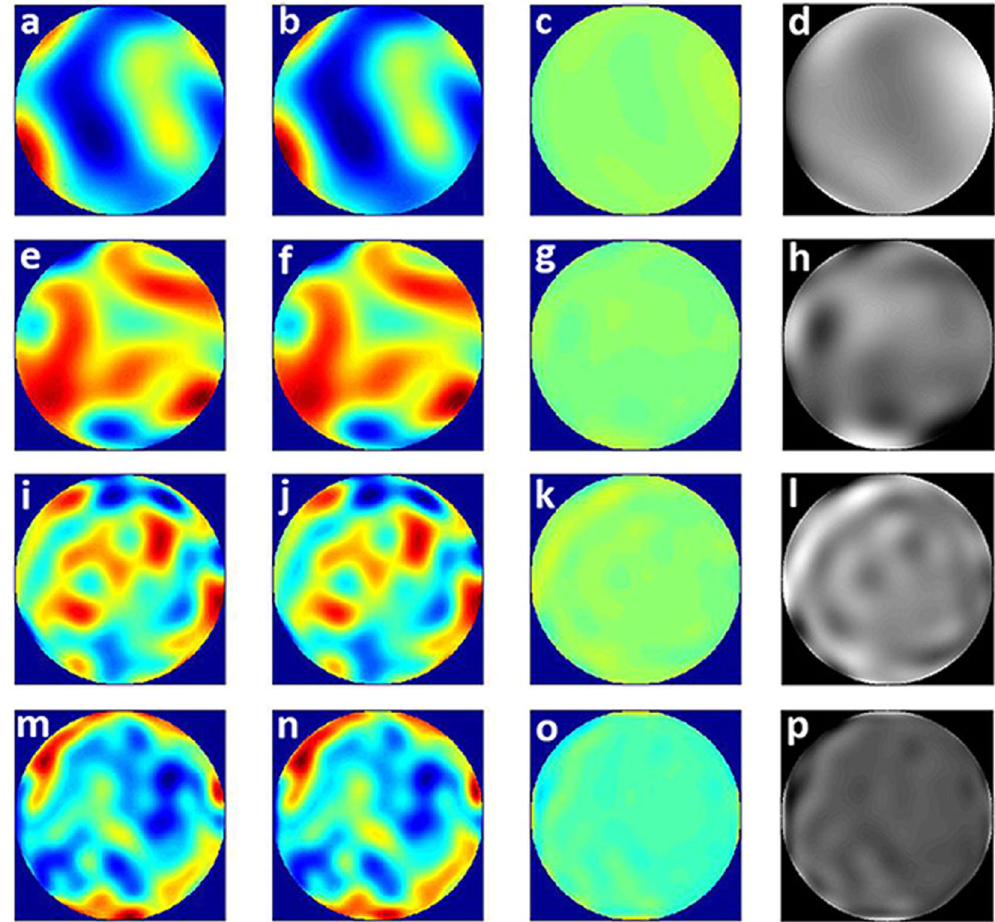
Figure 6. ( a ) Injected WFE map using 45 Zernike modes, ( b ) WFE map for the simulated test based on 45 Zernike modes, ( c ) difference between WFE ( a , b ). ( e ) Injected WFE map using 91 Zernike modes, ( f ) WFE map for the simulated test based on 91 Zernike modes, ( g ) difference between WFE ( e , f ). ( i ) Injected WFE map using 153 Zernike modes, ( j ) WFE map for the simulated test based on 153 Zernike modes, ( k ) difference between WFE ( I , j ). ( m ) Injected WFE map using 231 Zernike modes, ( n ) WFE map for the simulated test based on 231 Zernike modes, ( o ) difference between WFE ( m , n ). ( d , h , l ) and ( p ) represent the grey scale maps of WFE ( c , g , k ) and ( o ). The amplitude from white to black is equal to peak to valley.